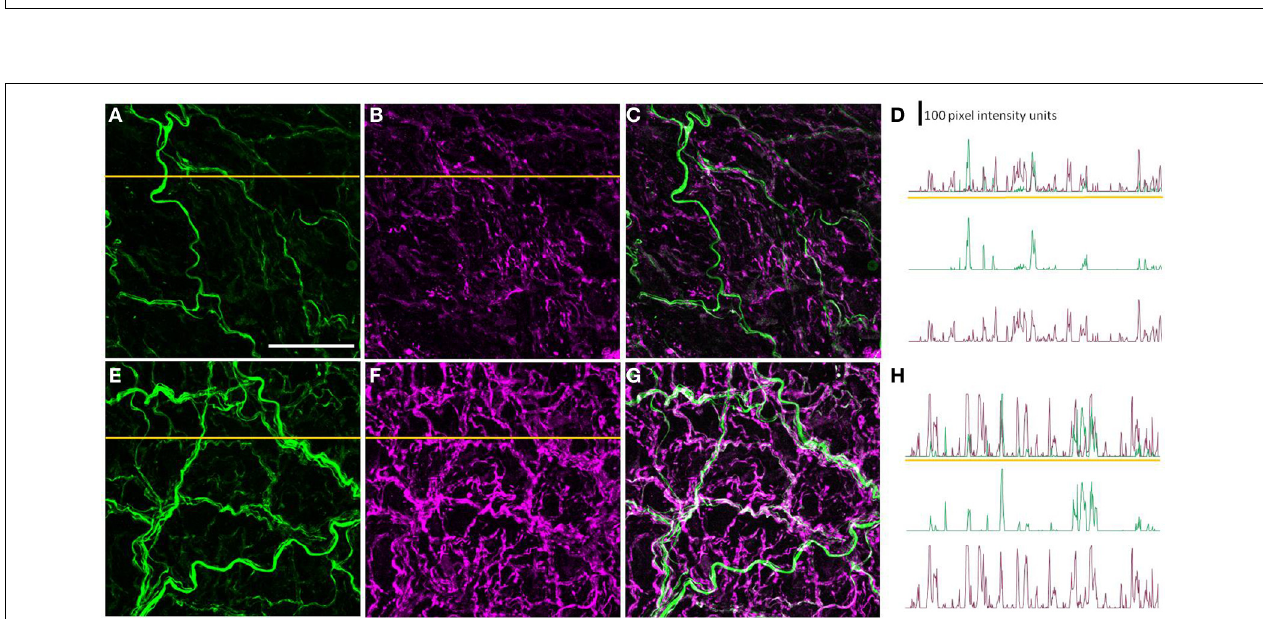
(STZ-LI). In both vessels, the majority of nerve fibers in the perivascular nerve plexus were NPY-IR and only a few axons were CGRP-IR. In comparison with the PMA from a control rat, immunofluorescence for NPY was increased in the PMA from the STZ-LI rat. The images were collected with a × 63 objective and the scale bar in (A) indicates 50 μ m and applies to all images.